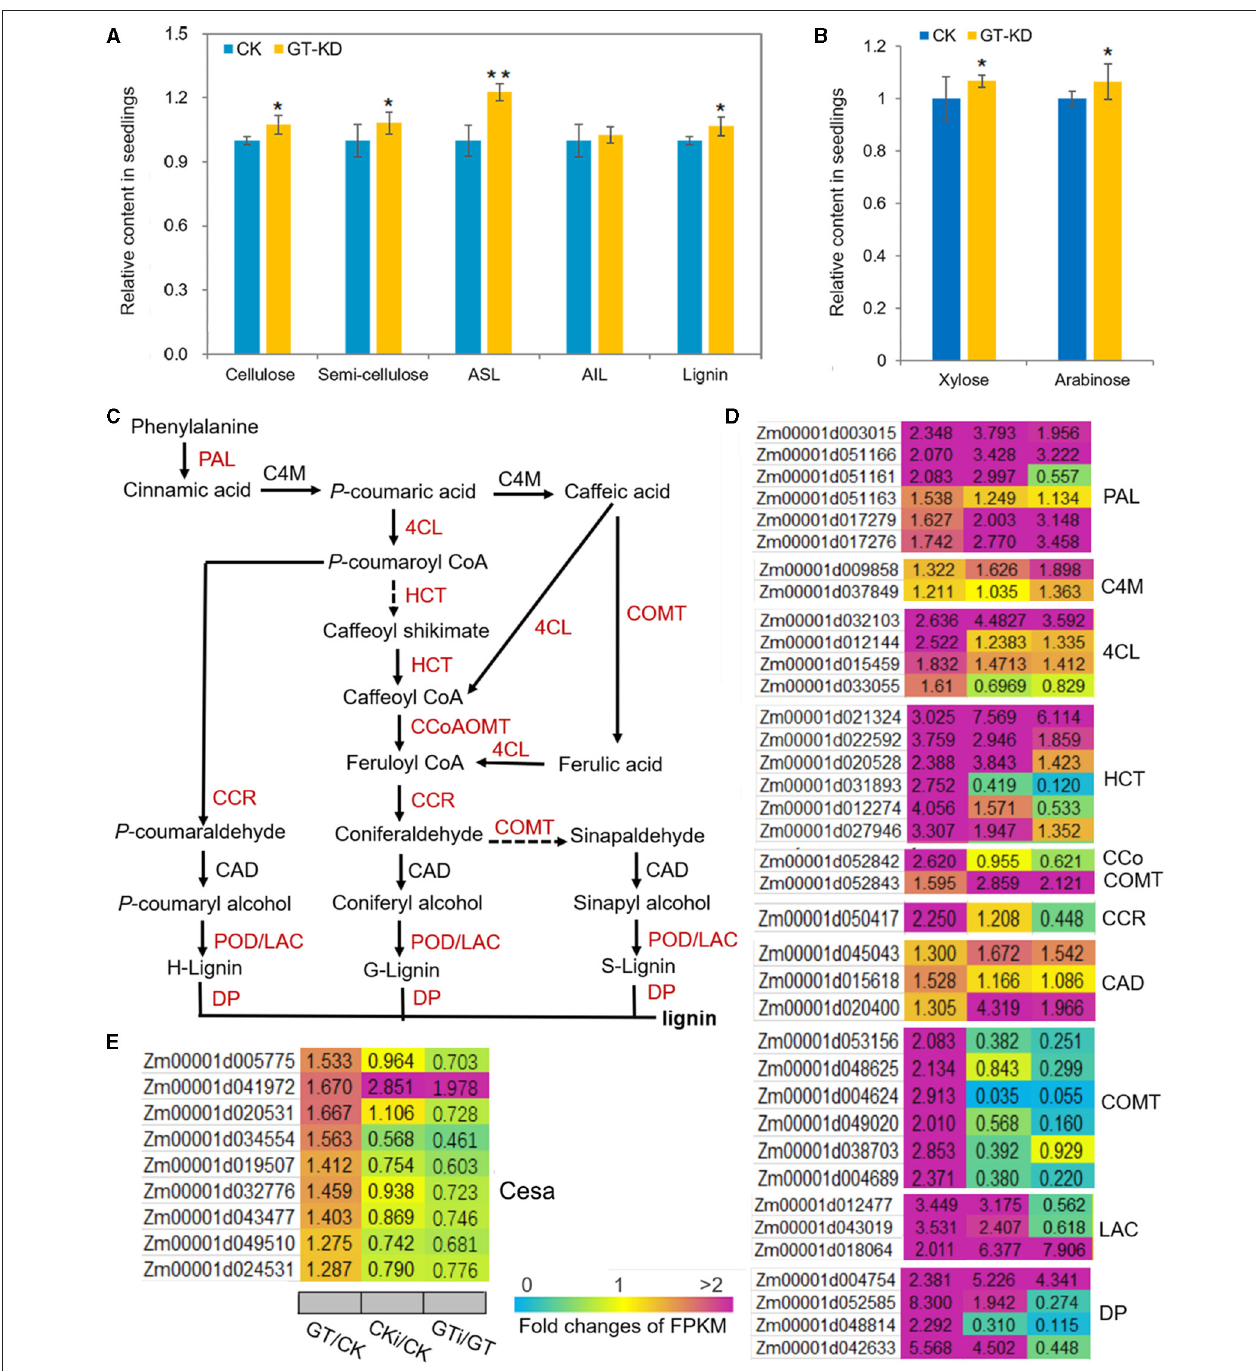
FIGURE 8 | The contents of the major plant cell wall components and critical genes in the lignin biosynthesis pathway are upregulated in ZmGT-3b knockdown maize seedlings. (A) Cellulose, semi-cellulose, acid-soluble lignin (ASL), and lignin contents were significantly higher in 12 DAG GT-KD vs. CK (LH244, wild type) seedlings, while the acid-insoluble lignin (AIL) contents were similar. (B) Both arabinose and xylose levels were significantly higher in GT-KD seedlings than in CK seedlings. Values are the mean ± SD ( n = 3). The asterisks represent a significant difference at * p < 0.05, ** p < 0.01 (according to the paired Student’s t -test). (C) The general lignin biosynthesis pathway includes the related enzymes. Red indicates significantly upregulated, and black indicates not significantly upregulated, in GT-KD seedlings. (D) Relative expression levels (fold) of genes are involved in lignin biosynthesis (D) and cellulose-synthase genes (E) in GT-KD seedlings. The data were obtained by transcriptome sequencing of ZmGT-3b knockdown (GT) and CK seedlings with (CKi and GTi) or without inoculation (CK and GT). PAL, phenylalanine ammonia-lyase; C4M, cinnamate 4-monooxygenase; 4CL, 4-coumarate CoA ligase; HCT, hydroxycinnamoyl-CoA shikimate/quinate hydroxycinnamoyl transferase; CCoAOMT, caffeoyl-CoA O -methyltransferase; CCR, cinnamoyl-CoA reductase; CAD, cinnamyl alcohol dehydrogenase; COMT, caffeic acid O -methyltransferase; LAC, laccase; POD, peroxidase; DP, dirigent protein (DP).